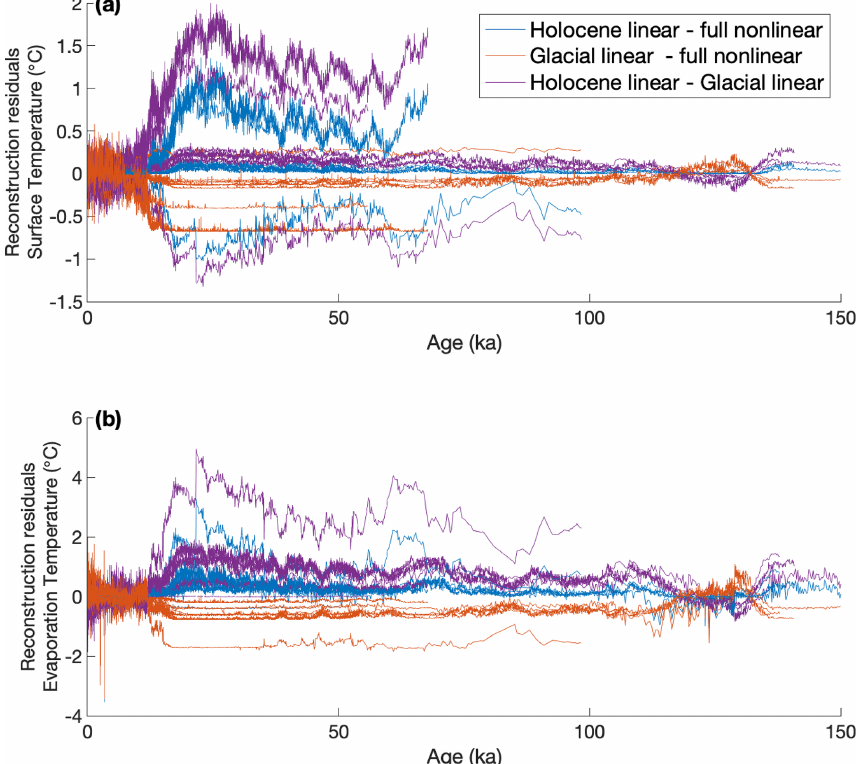
Figure 10. Differences between reconstructed (a) T s and (b) T 0 using different reconstruction techniques for multiple core sites. Blue lines show the difference between our full nonlinear reconstruction and a linear reconstruction using β and γ slopes linearized around Holocene conditions. Red lines show the difference between our full nonlinear reconstruction and a linear reconstruction using slopes linearized around glacial conditions. Purple lines show the difference between the two linear